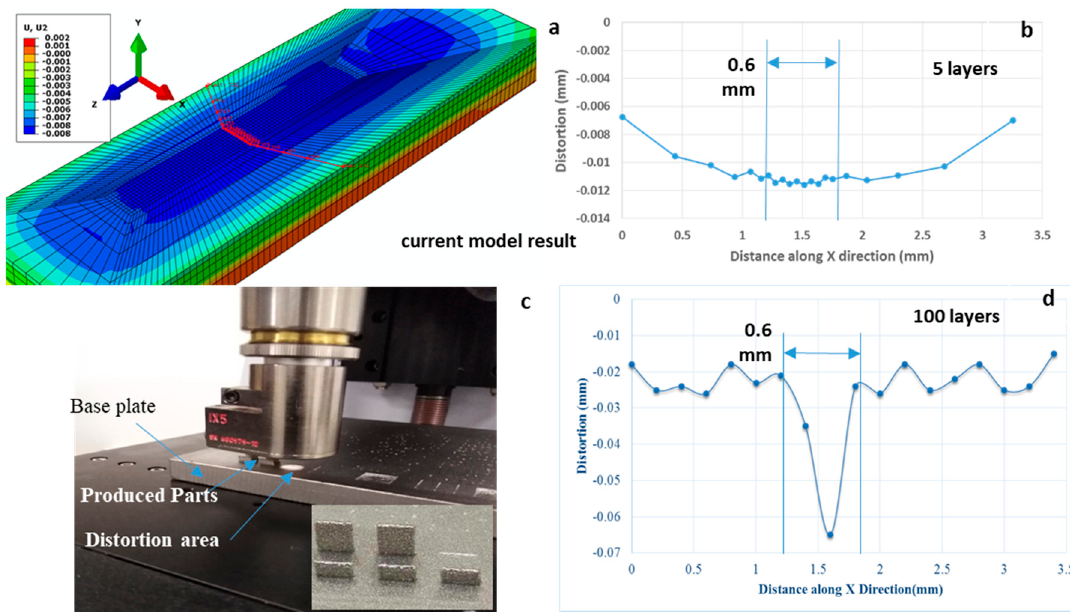
Figure 19. ( a ) Thermal distortion of the base plate along the X-axis. ( b ) Thermal distortion curve of the base plate along the X-axis. ( c ) Thermal distortion of the experimental base plate along the X-axis. ( d ) Thermal distortion curve of the experimental base plate along the X-axis.